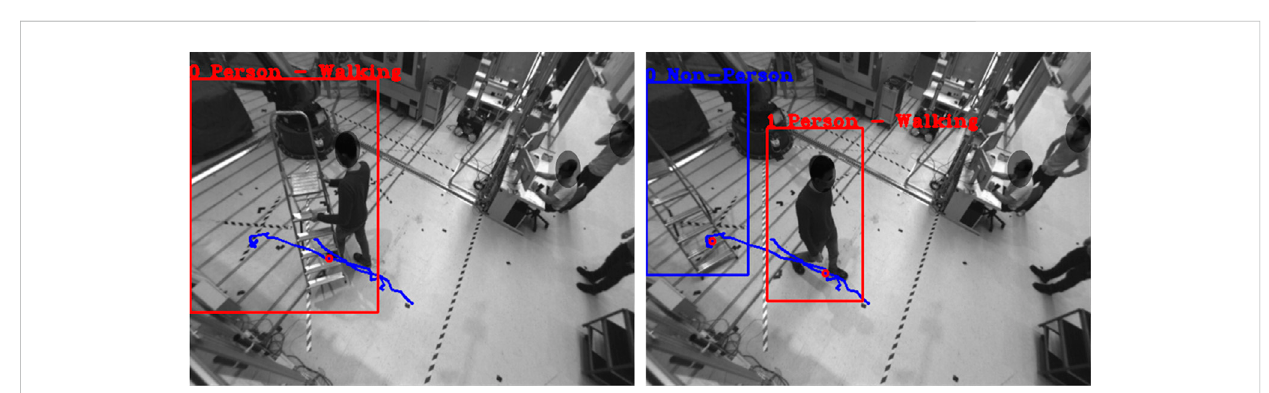
FIGURE 9 Object ID of human changes to ladder and human is recognized as new object: (Left) human and ladder interact before ID change, (Right) human and ladder separate after ID change.